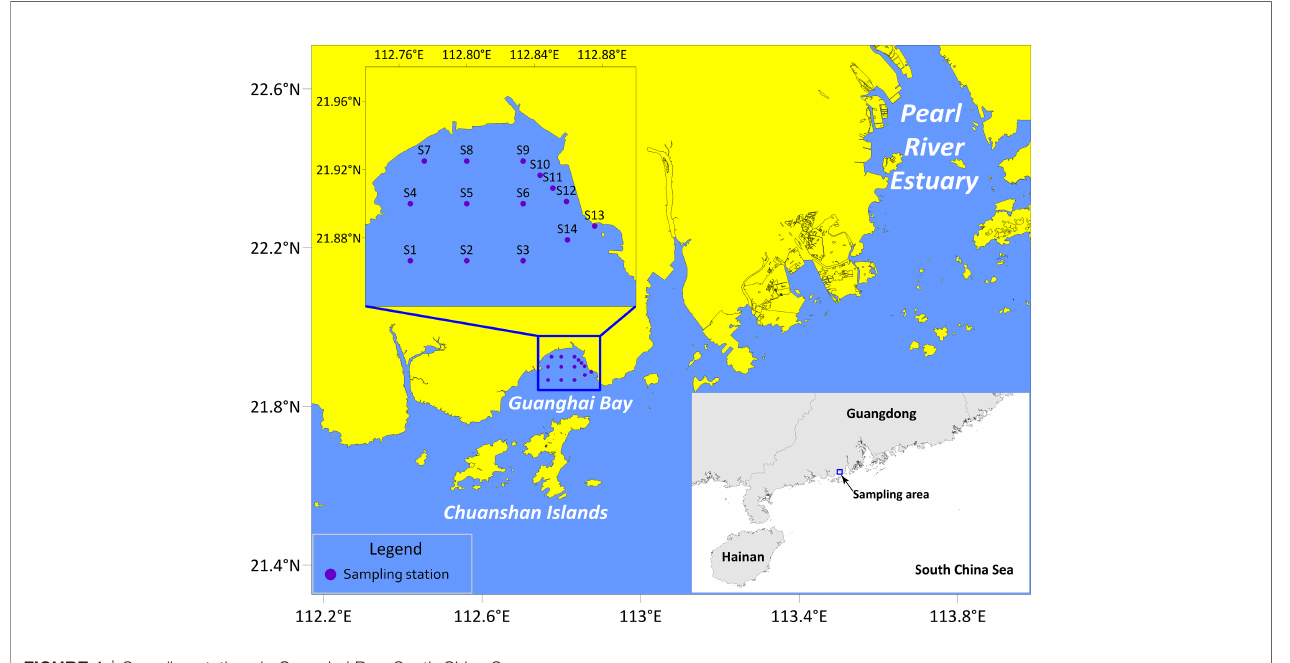
FIGURE 1 | Sampling stations in Guanghai Bay, South China